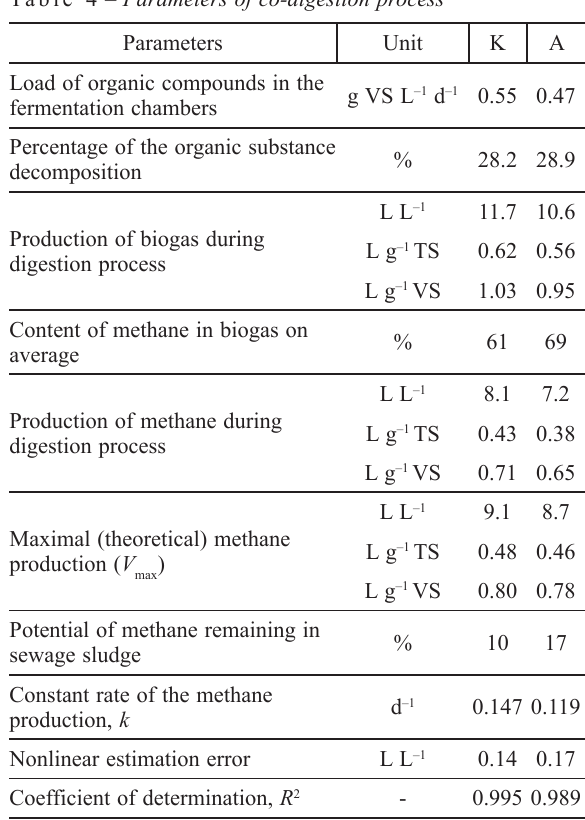
Fig. 4 – Volume of methane during anaerobic digestion pro- cess